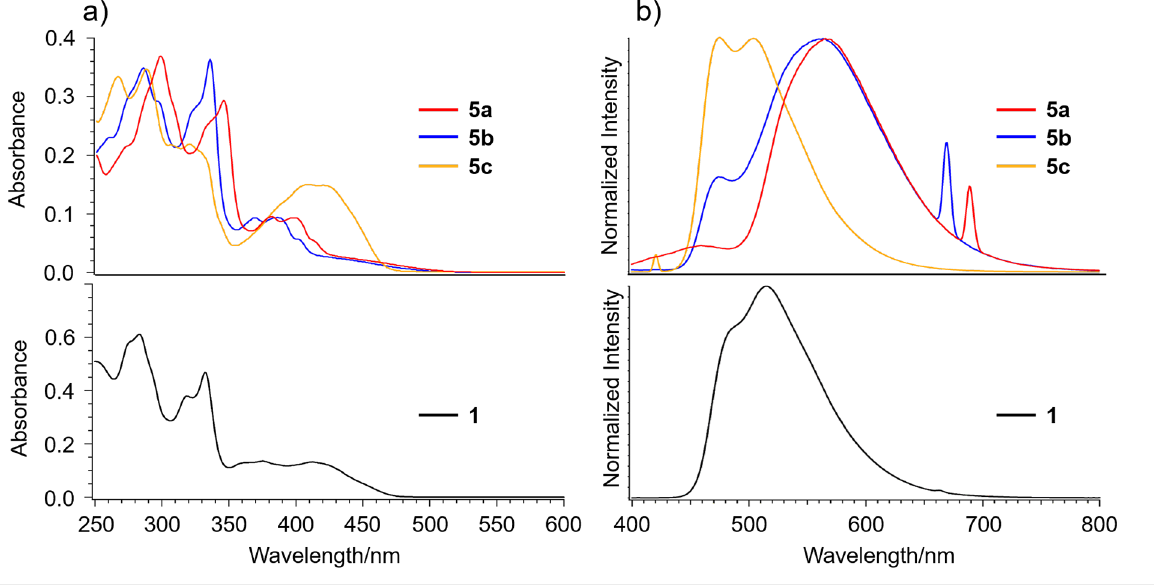
Figure 6: a) UV–vis spectra and b) emission spectra of 1 and dialkoxides 5a – c . For all the spectra, the concentration was 1 × 10 − 5 M in CH 2 Cl 2 . Exci- tation wavelength: 332 nm for 1 ; 345 nm for 5a ; 335 nm for 5b ; 319 nm for 5c .